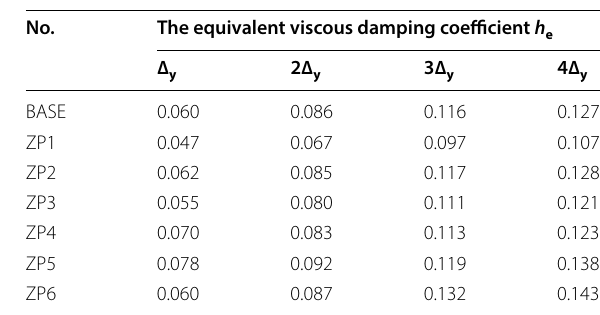
Table 5 The equivalent viscous damping coefficient of the